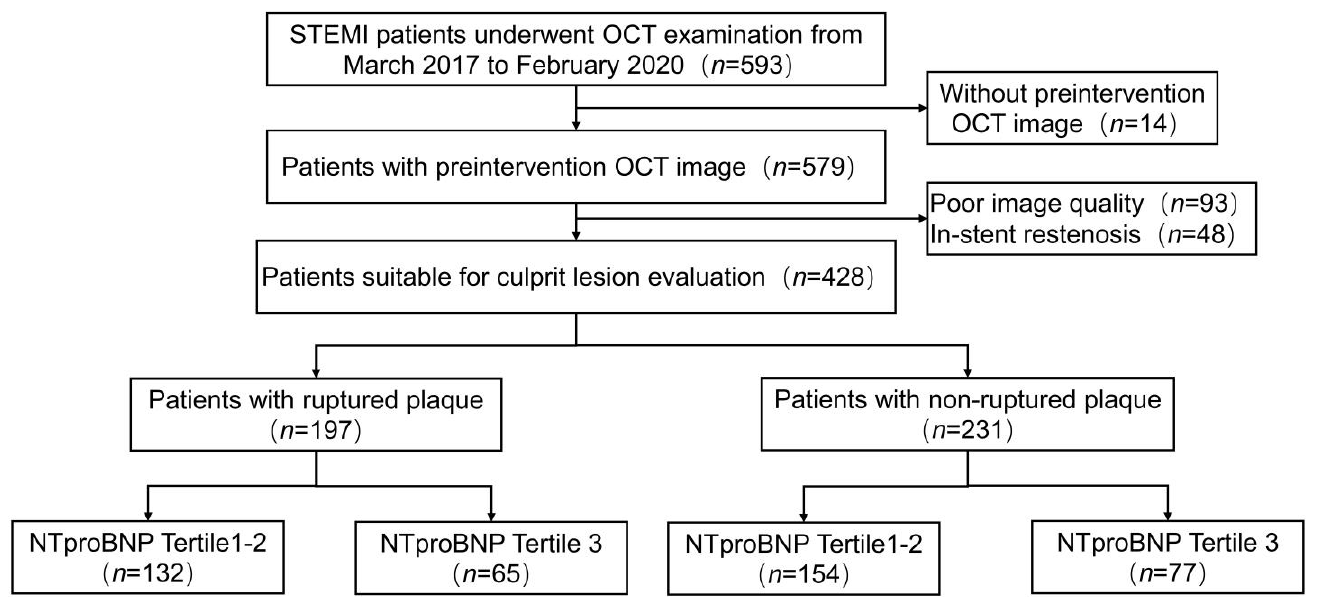
Figure 1. Study flow chart. OCT, optical coherence tomography; STEMI, ST-Segment–Elevation Myocardial Infarction.